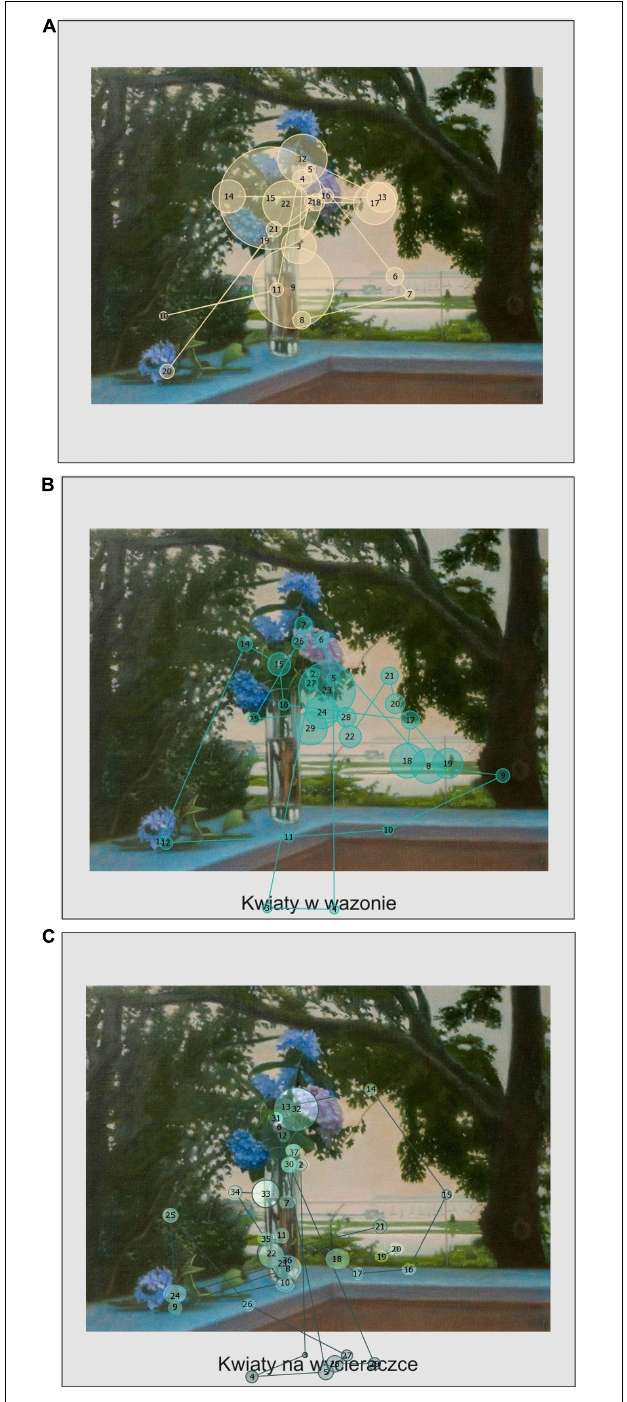
FIGURE 2 | Examples of scanpaths from selected participants for a painting without semantic violations in three conditions. (A) Untitled, (B) consistent title (English translation: Flowers in a vase), (C) inconsistent title (English translation: Flowers on a doormat). The circles represent fixations, solid lines represent saccades, and the numbers correspond to indexes of fixations. The size of circles depicts relative fixation duration. Painting by Levenstein (2012), Orient at Dusk (Flowers in Glass Vase on Corner of Deck), oil on linen, 38 × 51 cm, courtesy of Matvey Levenstein and Galleria Lorcan